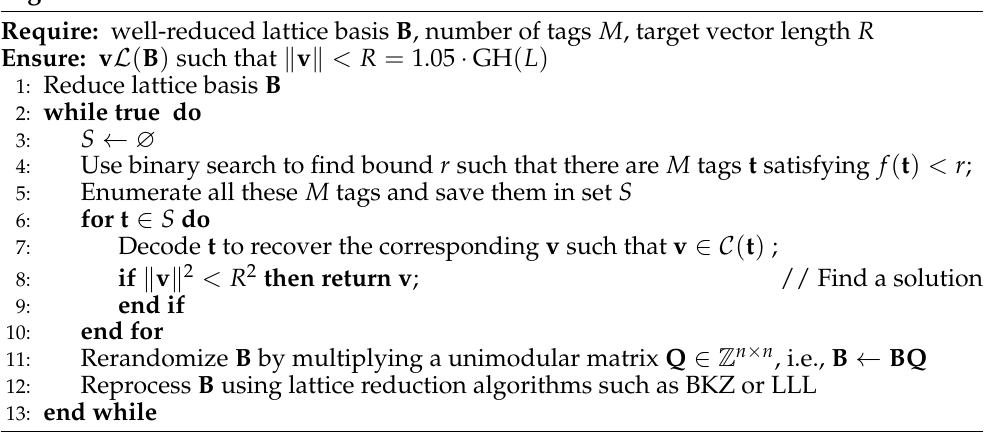
Algorithm 1 Discrete Pruned